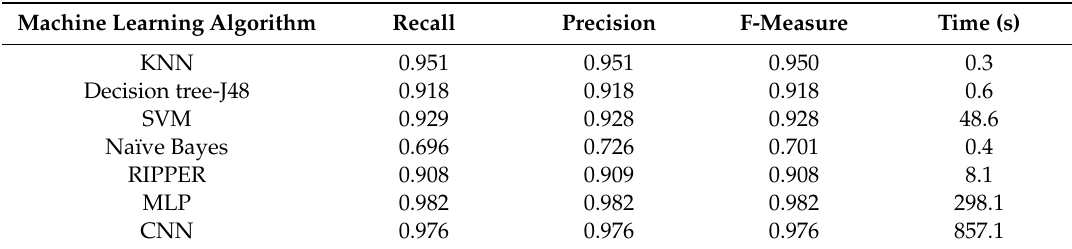
Table 2. Classification results of machine and deep learning. Abbreviations: k-nearest neighbor (KNN);